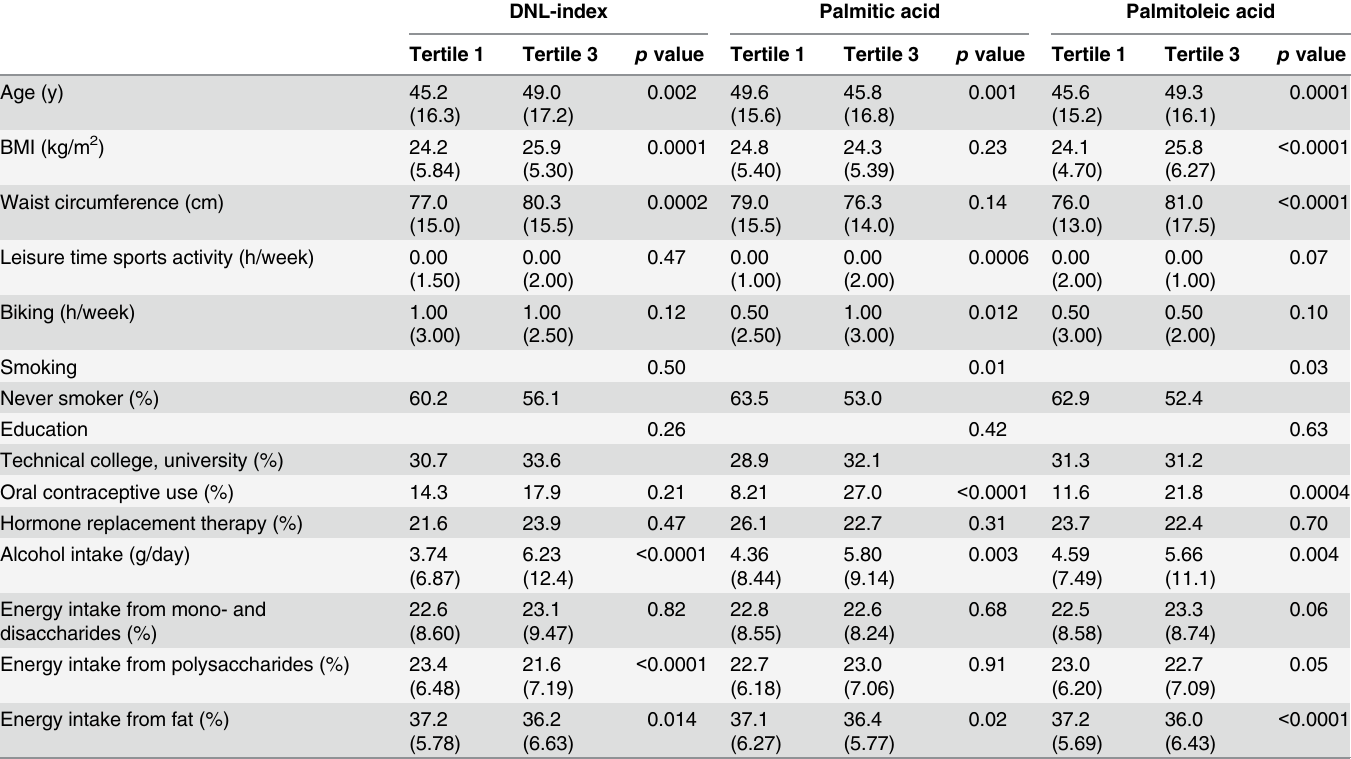
Table 2. Characteristics by tertiles of the DNL-index (16:0 / 18:2n-6), palmitic acid (16:0) and palmitoleic acid (16:1n-7) in women, EPIC-Potsdam study (n = 989) a